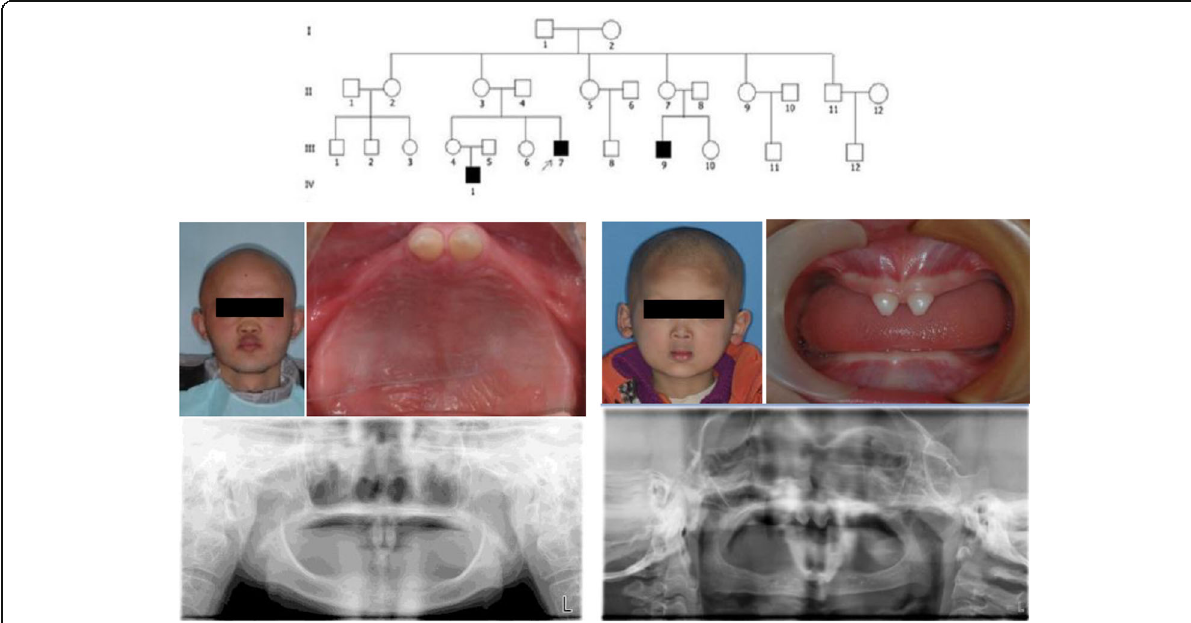
Fig. 1 The family tree of C.878 T > G gene mutation patients affected by HED (upper) and their phenotypic appearance of the proband (lower left) and his nephew (lower right). Notes: HED, hypohidrotic ectodermal dysplasia